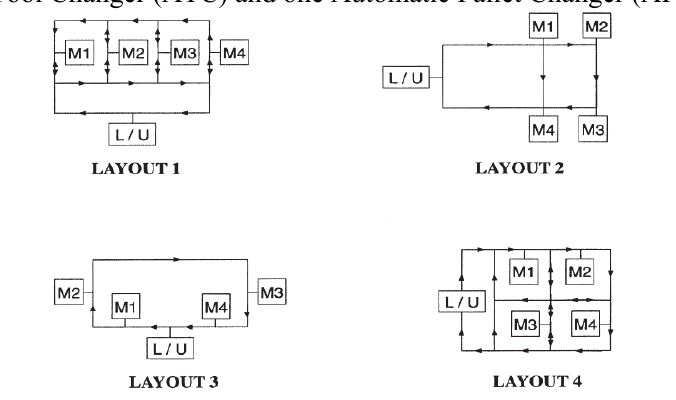
Fig. 1 . Layout arrangements in example